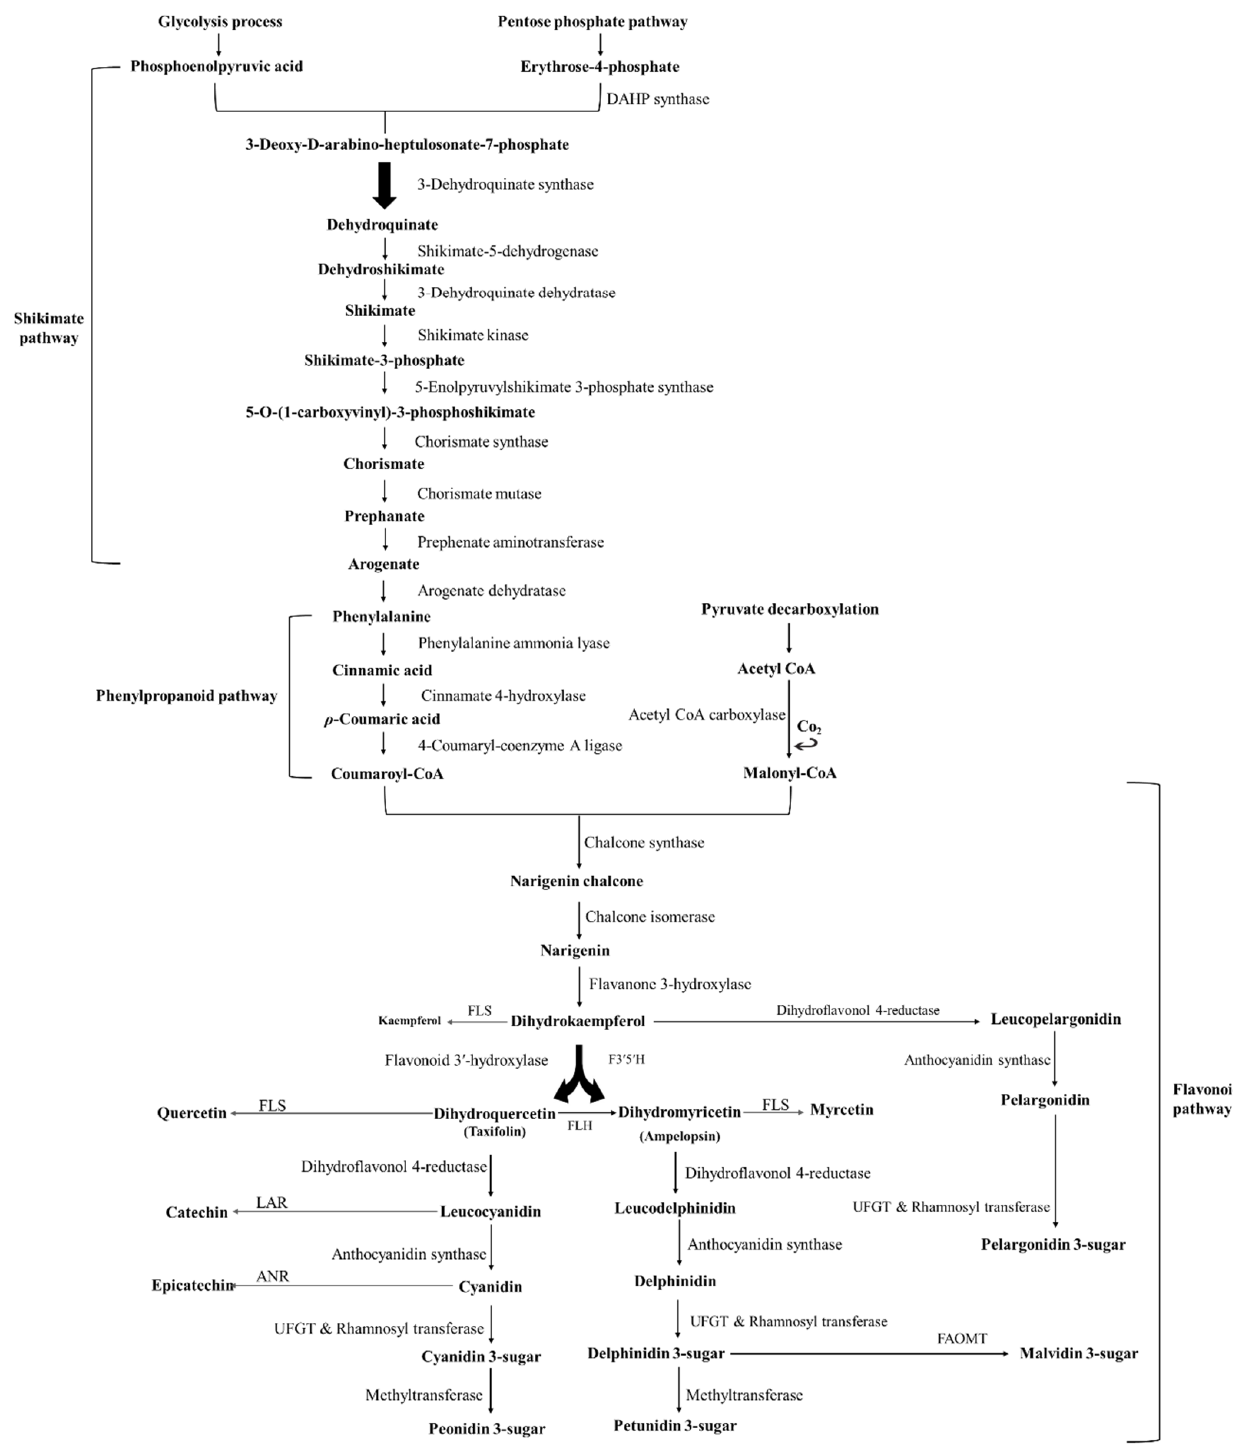
Figure 1. Biosynthesis pathways of the main anthocyanins found in foods. DAHP: 3-Deoxy-D-arabinoheptulosonate 7-phosphate; CoA: coenzyme A; F3′5′H: Flavonoid 3′, 5′-hydroxylase; FLH: Flavanone 3-hydroxylase; FLS: Flavonol synthase; LAR: Leucoanthocyanidin reductase; ANR: Anthocyanidin reductase; UFGT: UDP glucose flavonoid 3 -O- glucosyltransferase; FAOMT: Flavonoid 3’, 5’-methyltransferase (adapted from [25]). Concerning the flavonoids (Figure 2), they represent about two-thirds of the total dietary phenolics consumed, and currently, more than 9000 different flavonoids have been identified so far [29,30]. They all possess a common flavan nucleus, i.e., a 15 carbon-